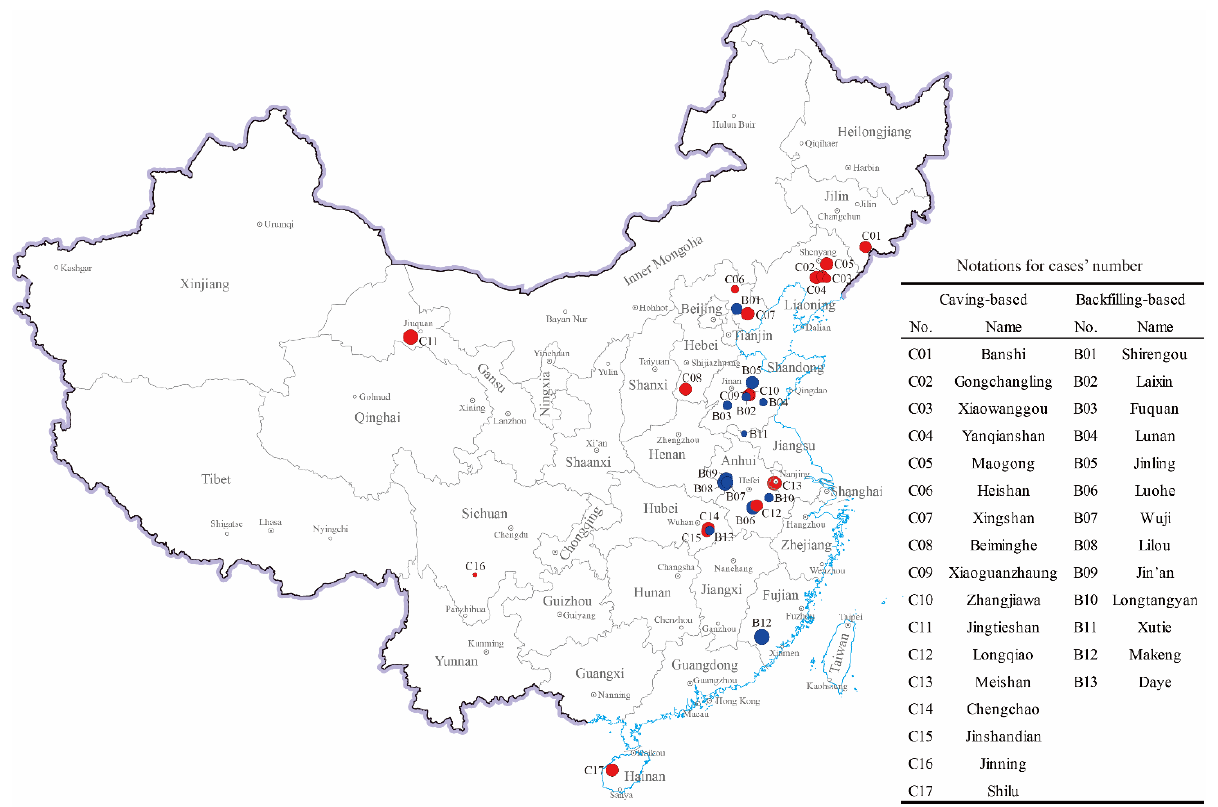
Figure 1. Distribution of underground iron mines involved in this study. The marks for case positions are colored according to the mining method they utilized, i.e., red and blue represent caving and backfilling methods, respectively. The size of the marks indicates their yields in 2019. Table 1. Energy conservation and carbon abatement